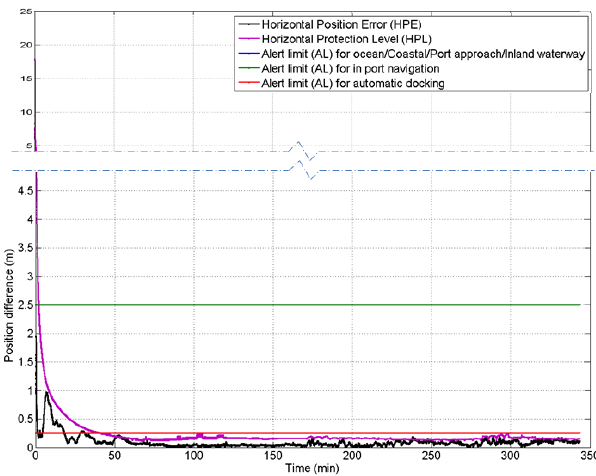
Figure 4. HPE against HPL along with AL from IMO standards. Figures 5 through 7 show correlation between HPE and HPL